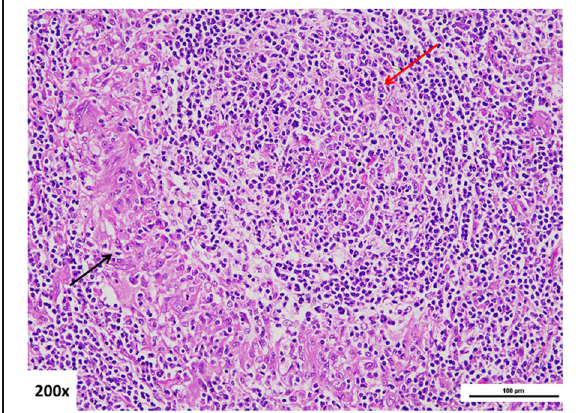
Fig. 2 (H&E stain): Wreath-like granuloma (black arrow) around the reactive follicles (red